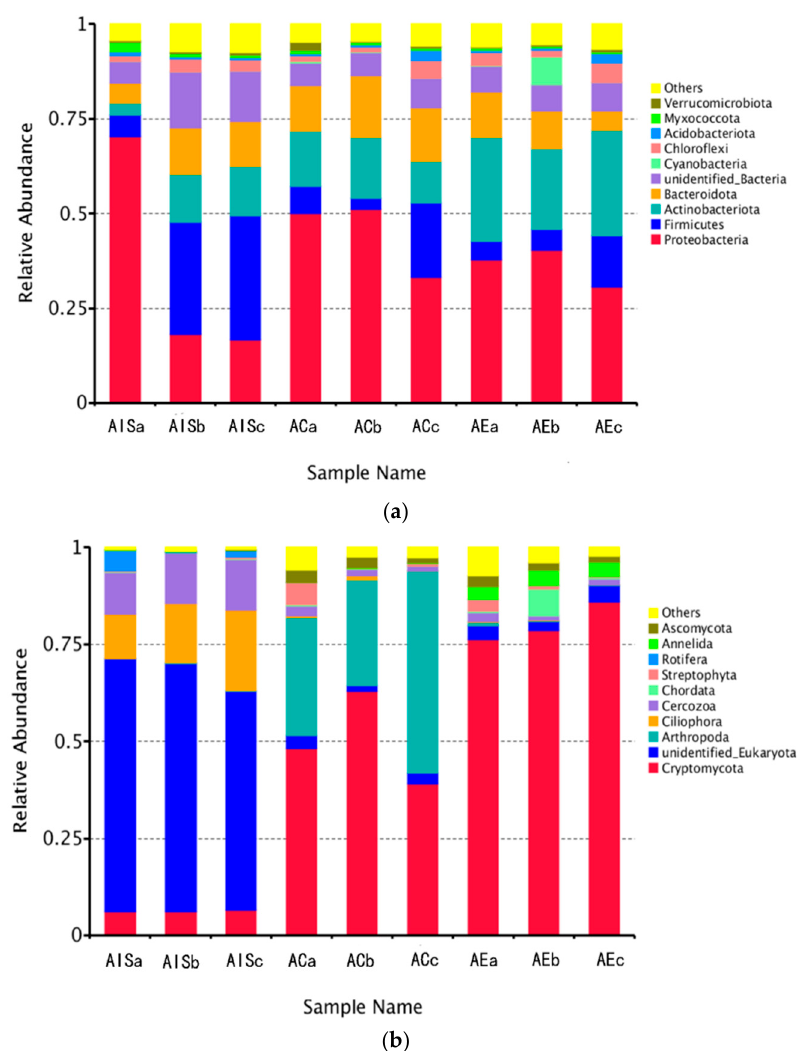
Figure 3. Relative abundances of active bacteria ( a ) and eukaryotes; ( b ) at phylum level in initial sludge (AIS) and final products of control (AC) and vermicompost (AE). a, b and c represent the triplicate of each sample.